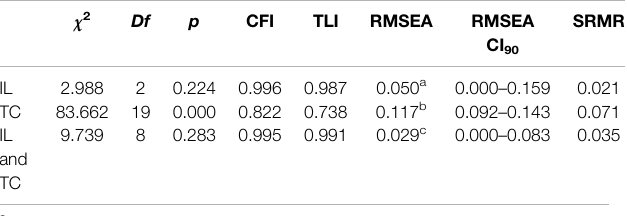
TABLE 1 | Results of CFAs of measurement models of IL and TC (separated and